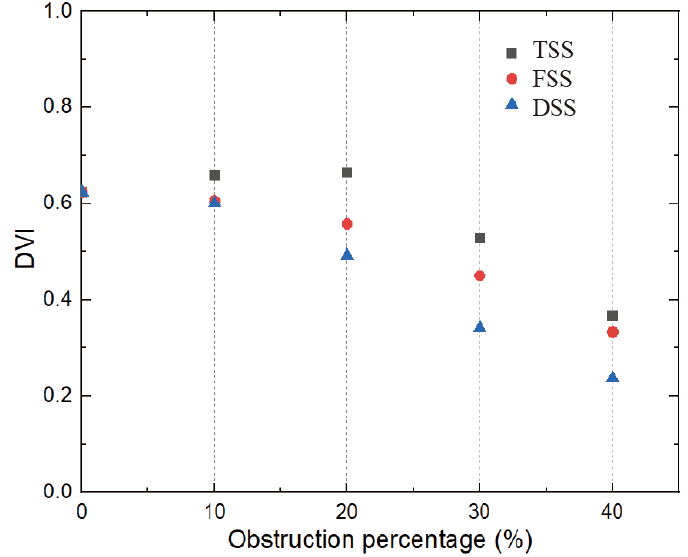
Figure 15. The relationship between obstruction percentage and Doppler velocity index ( t = 0.2 s).